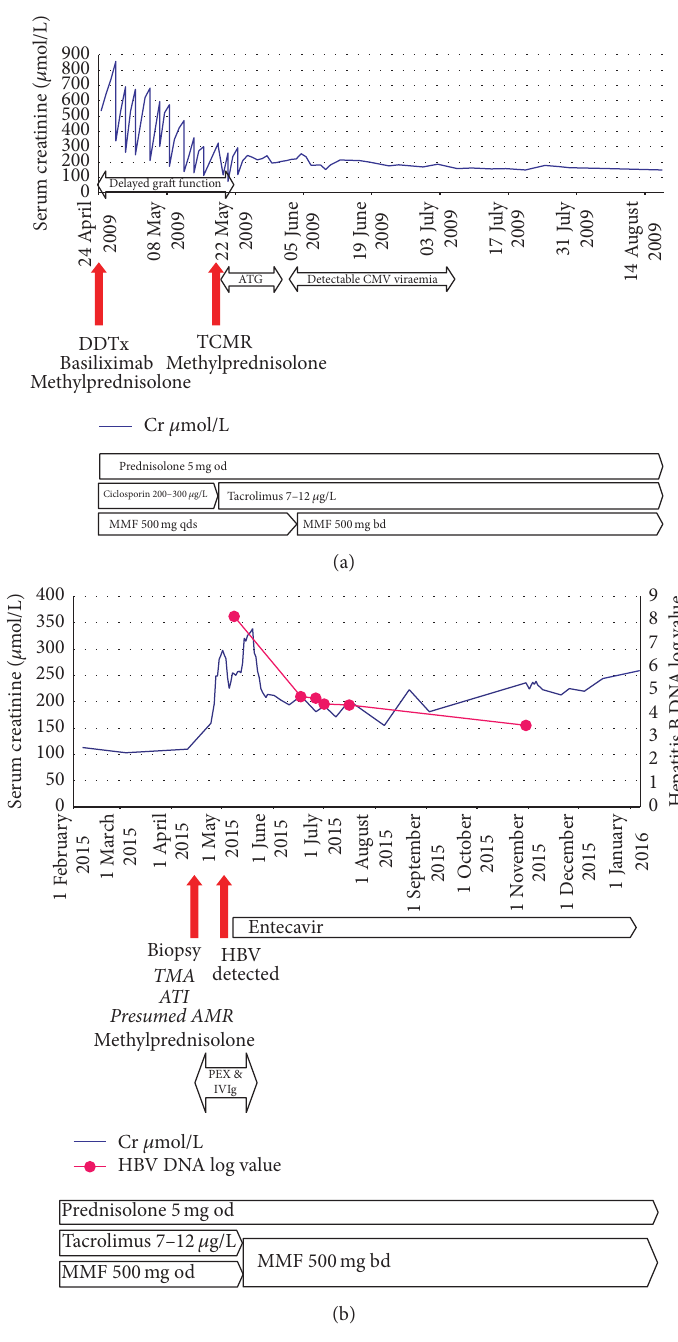
Figure 1: (a) Events following transplantation. (b) Events following his presentation with AKI.